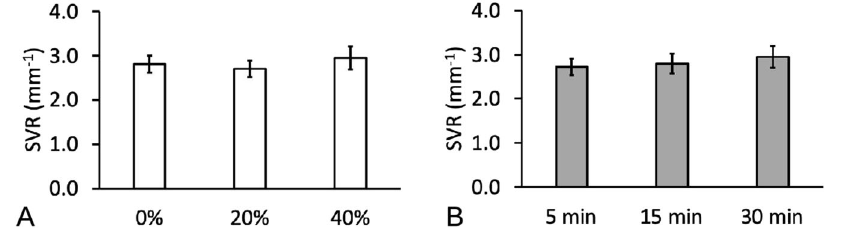
Fig. 5 Main effects plots of the surface area to volume ratio (SVR) of PLGA/PVA scaffold with respect to ( A ) sonication power, p W , and ( B ) soaking duration, t . Note that the value of the respective bars on each